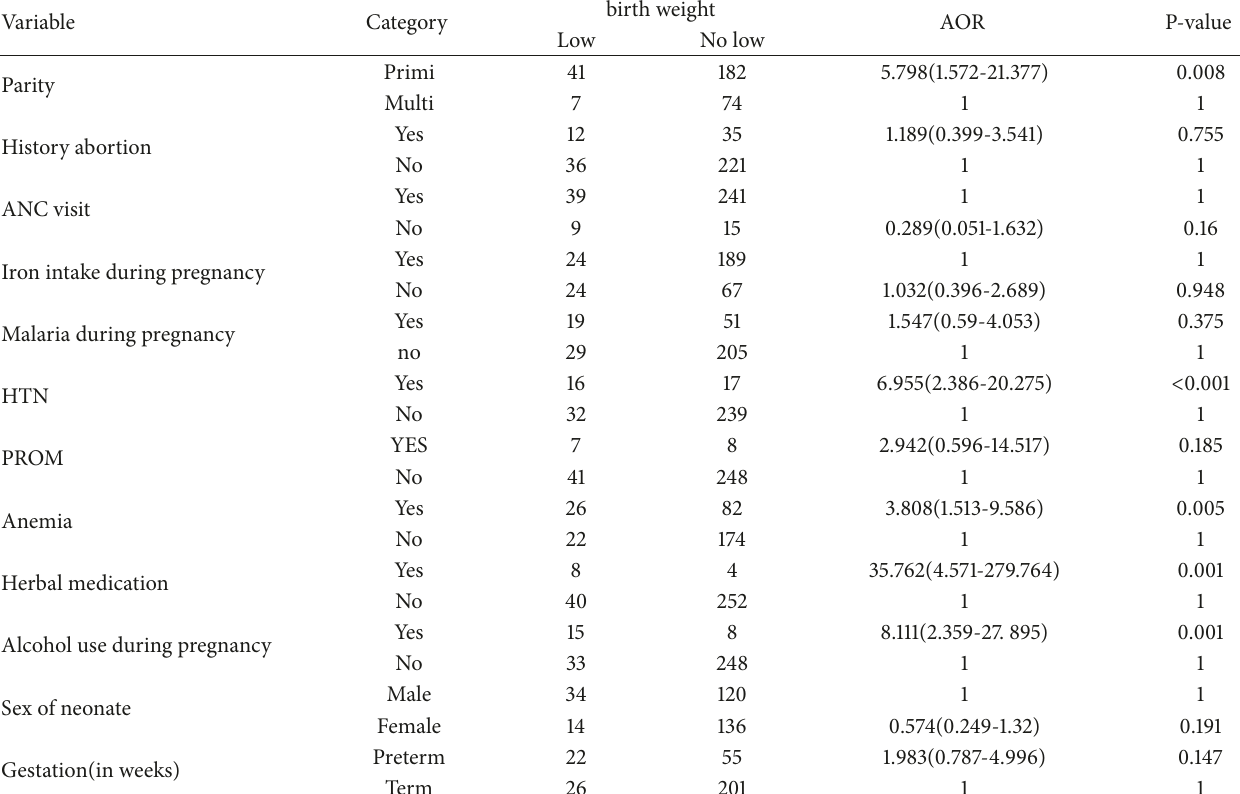
Table 3: The association between low birth weight and different factors among newborns delivered at Wolaita Sodo University teaching and referral hospital, Sothern Ethiopia,